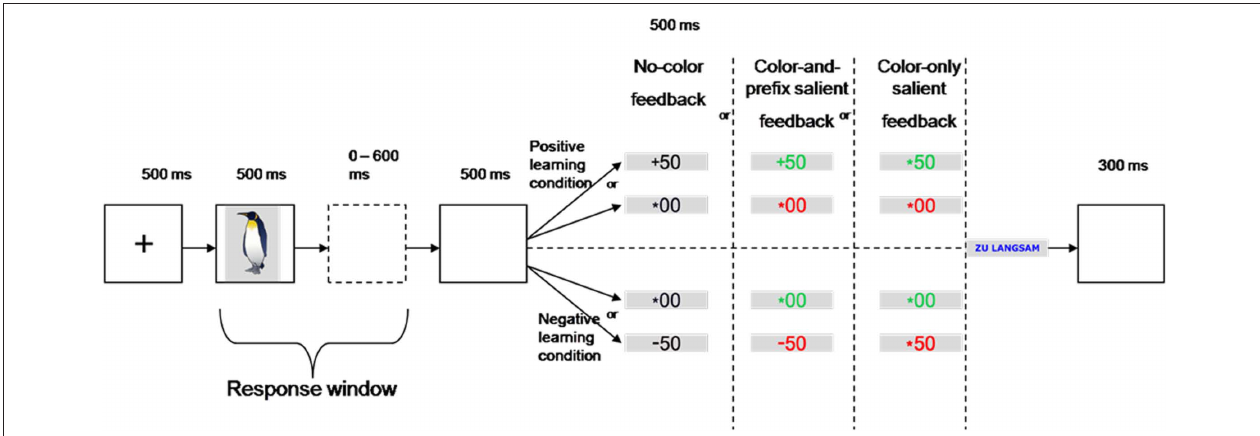
Figure 1 | Participants responded to an imperative stimulus picture with one of two response keys and had to learn the stimulus–response assignments by trial‑and‑error depending on the